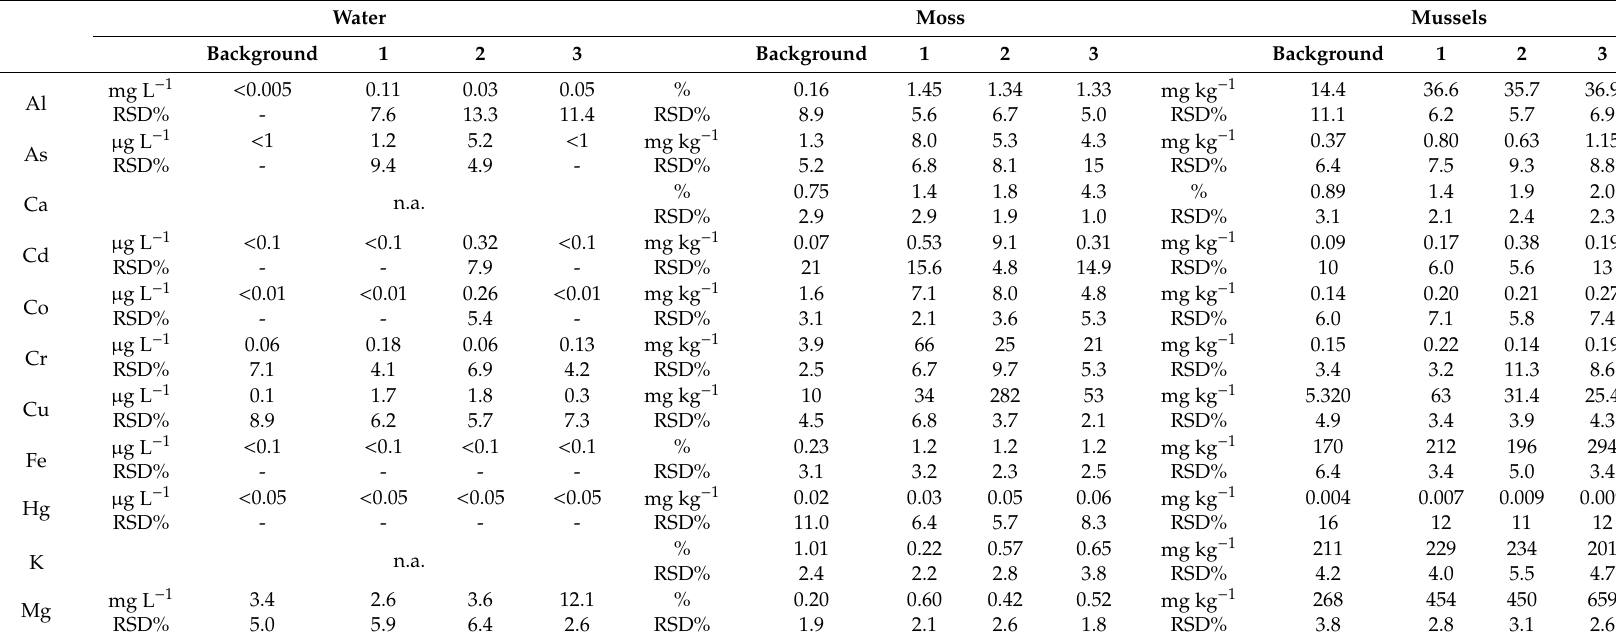
Table 1. Analyzed concentrations in water, moss, and mussel samples. For stations, please refer Figure 1; n.a.—not